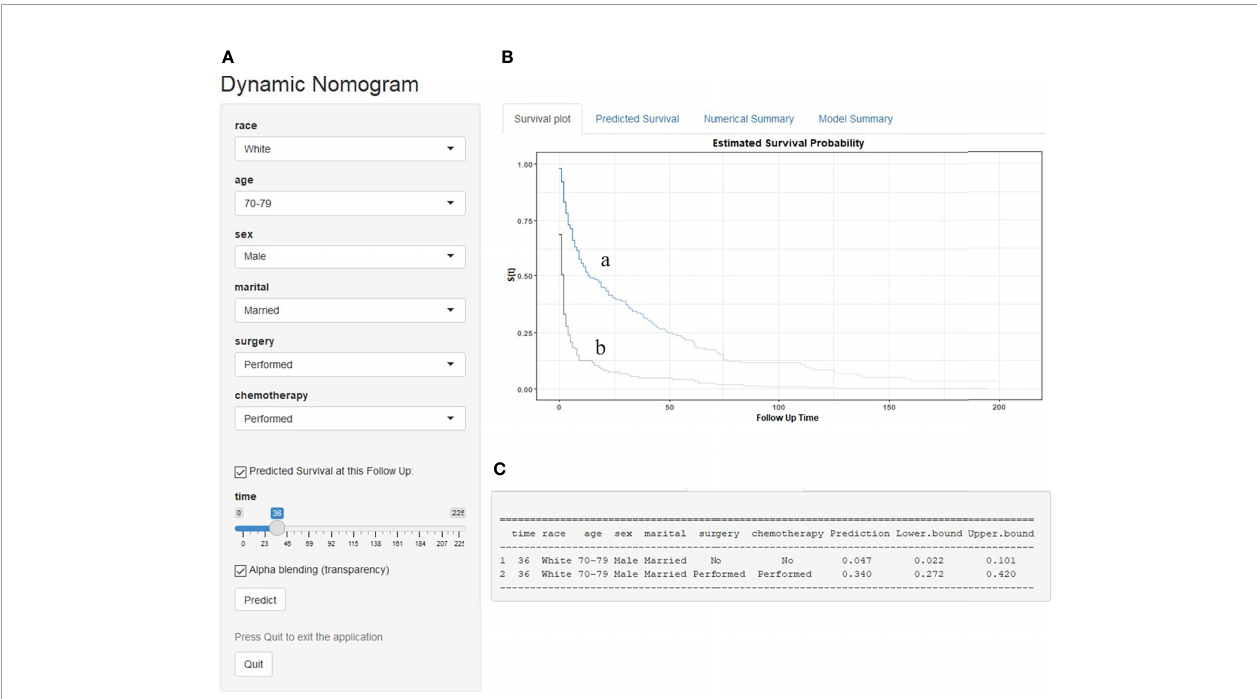
FIGURE 7 | An example to illustrate the use of the web-based survival rate calculator. (A) A 75-year-old married white man was diagnosed as PCNSL with DLBCL; if he refused chemotherapy and surgery, his 3-year OS rate is approximately only 4.7% (95% CI 0.022 – 0.101) (C); if he was given chemotherapy and surgery, his 3- year OS rate is approximately 34.0% (95% CI 0.272 – 0.420) (C) . (B) His survival curve depending on whether he was treated or not: received treatment (a) and refused treatment